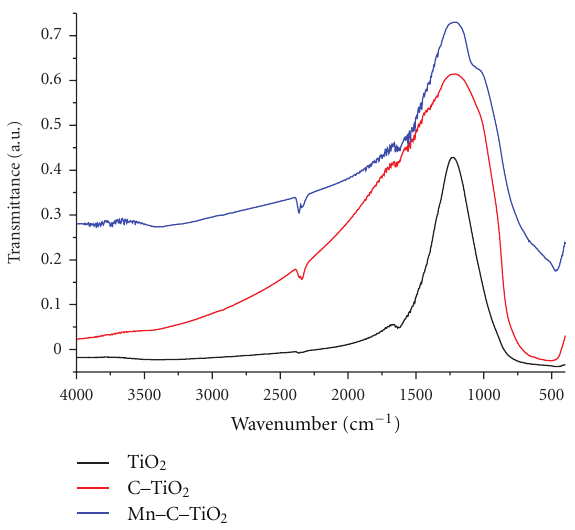
Figure 5: FT-IR spectra of TiO 2 , C–TiO 2 , and Mn–C–TiO 2